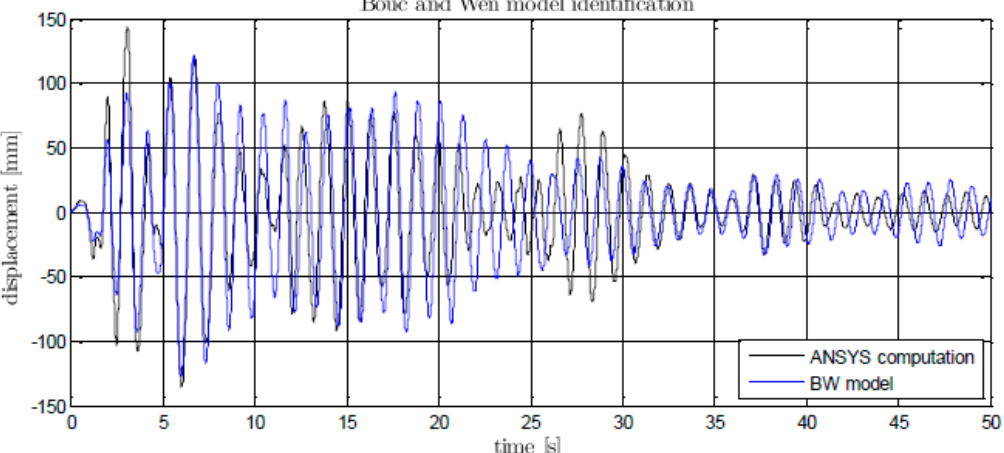
Figure 5: Displacement time history: comparison between BW identified model and ANSYS results (optimization of mass and damping of the BW SDOF